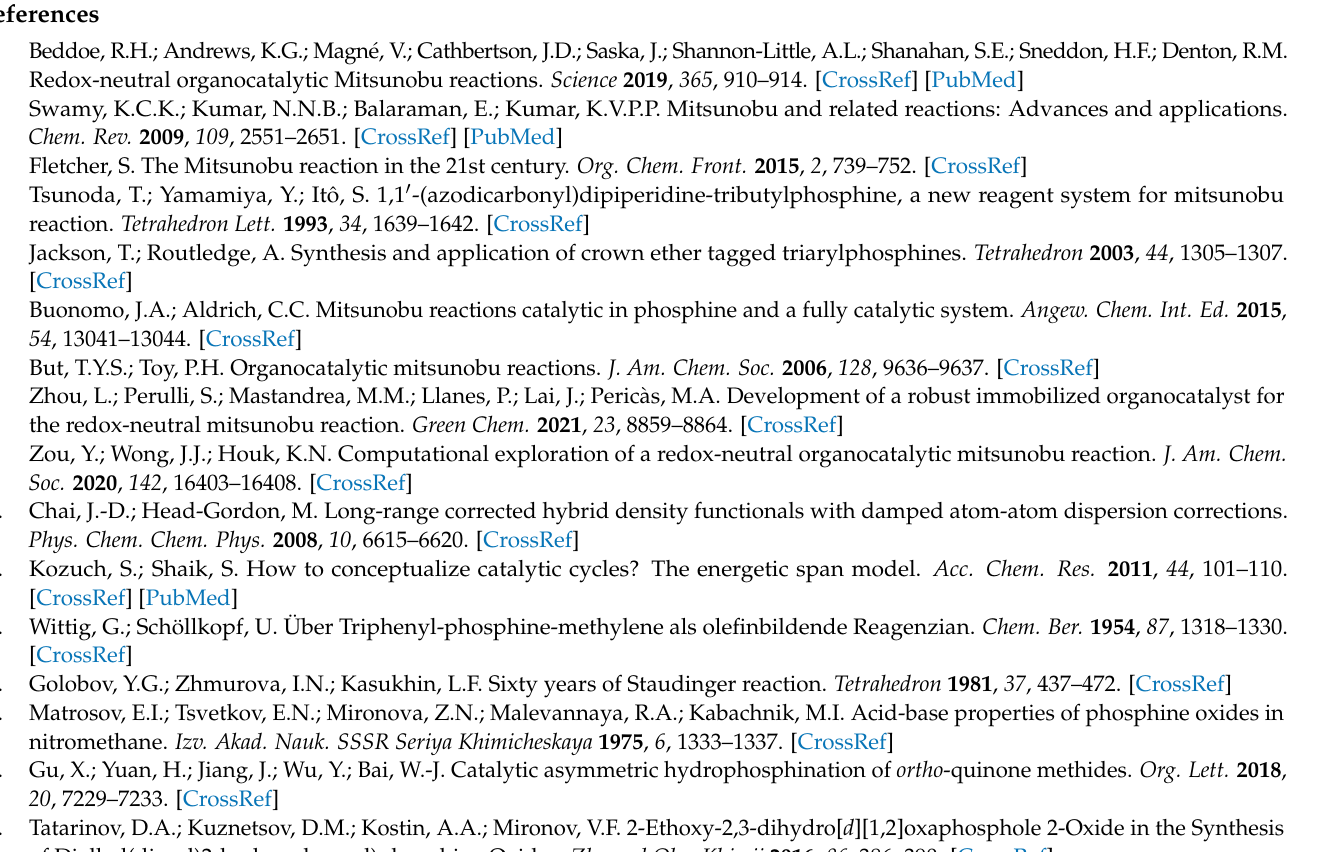
Table S1: Summary of multiple syntheses of 1a ; detailed experimental protocols, spectral information for novel compounds, and coordinates for computed ground-state and transition-state